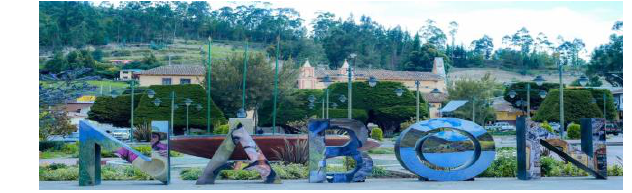
Figure 2 . The main square of